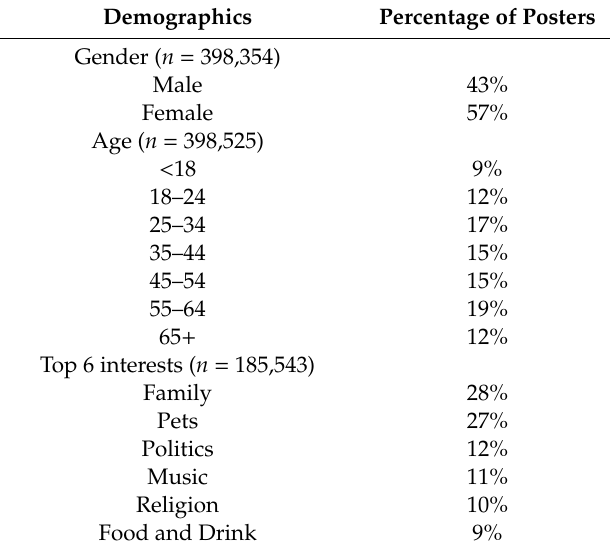
Table 3. Inferred demographic information of Twitter